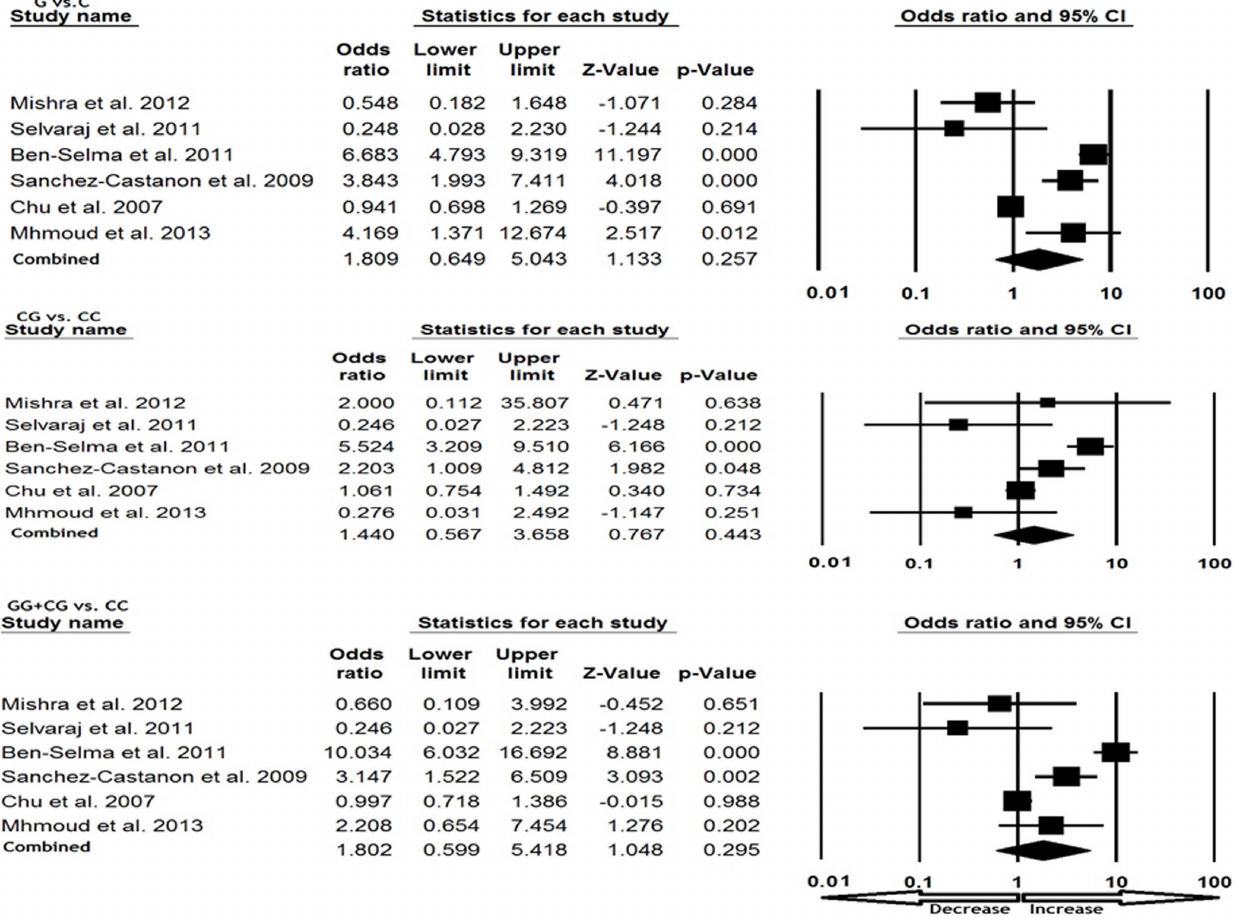
Figure 1. Forest plot analysis for assessing the overall TB risk associated with CCL5 28 C . G polymorphism. Note: The squares and horizontal lines correspond to the study-specific OR and 95% CI.